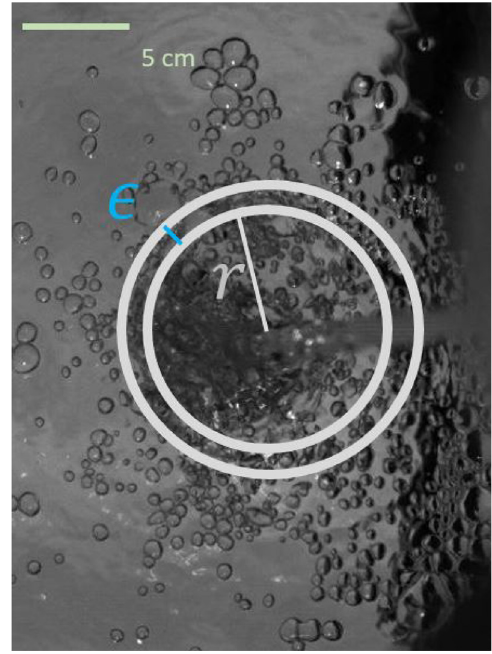
Fig. 2. Experimental picture taken from above, used to measure the density of bubbles at the surface of the container.